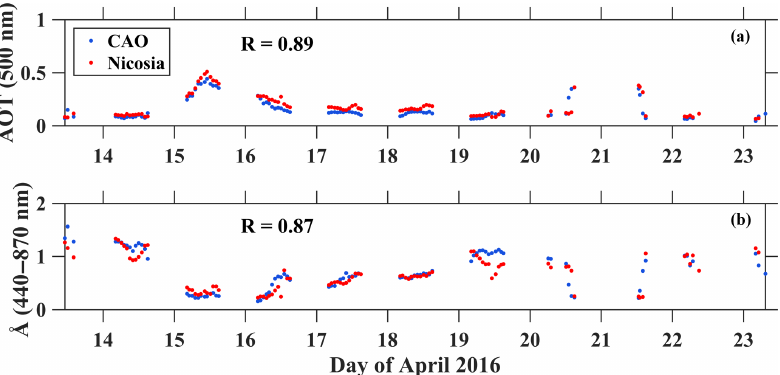
Figure 4. (a) AOT 500 and (b) Å 440 − 870 as measured with the sun photometers at CAO (blue circles) and Nicosia (red circles) from 13 to 24 April